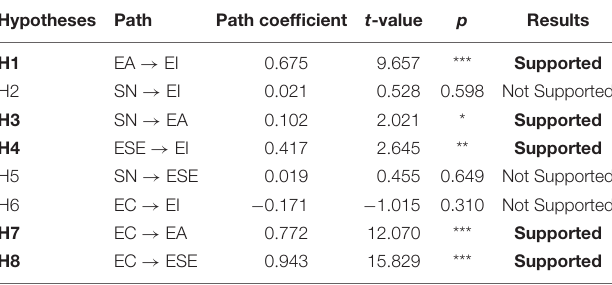
TABLE 5 | Summary of the hypothesis tests.